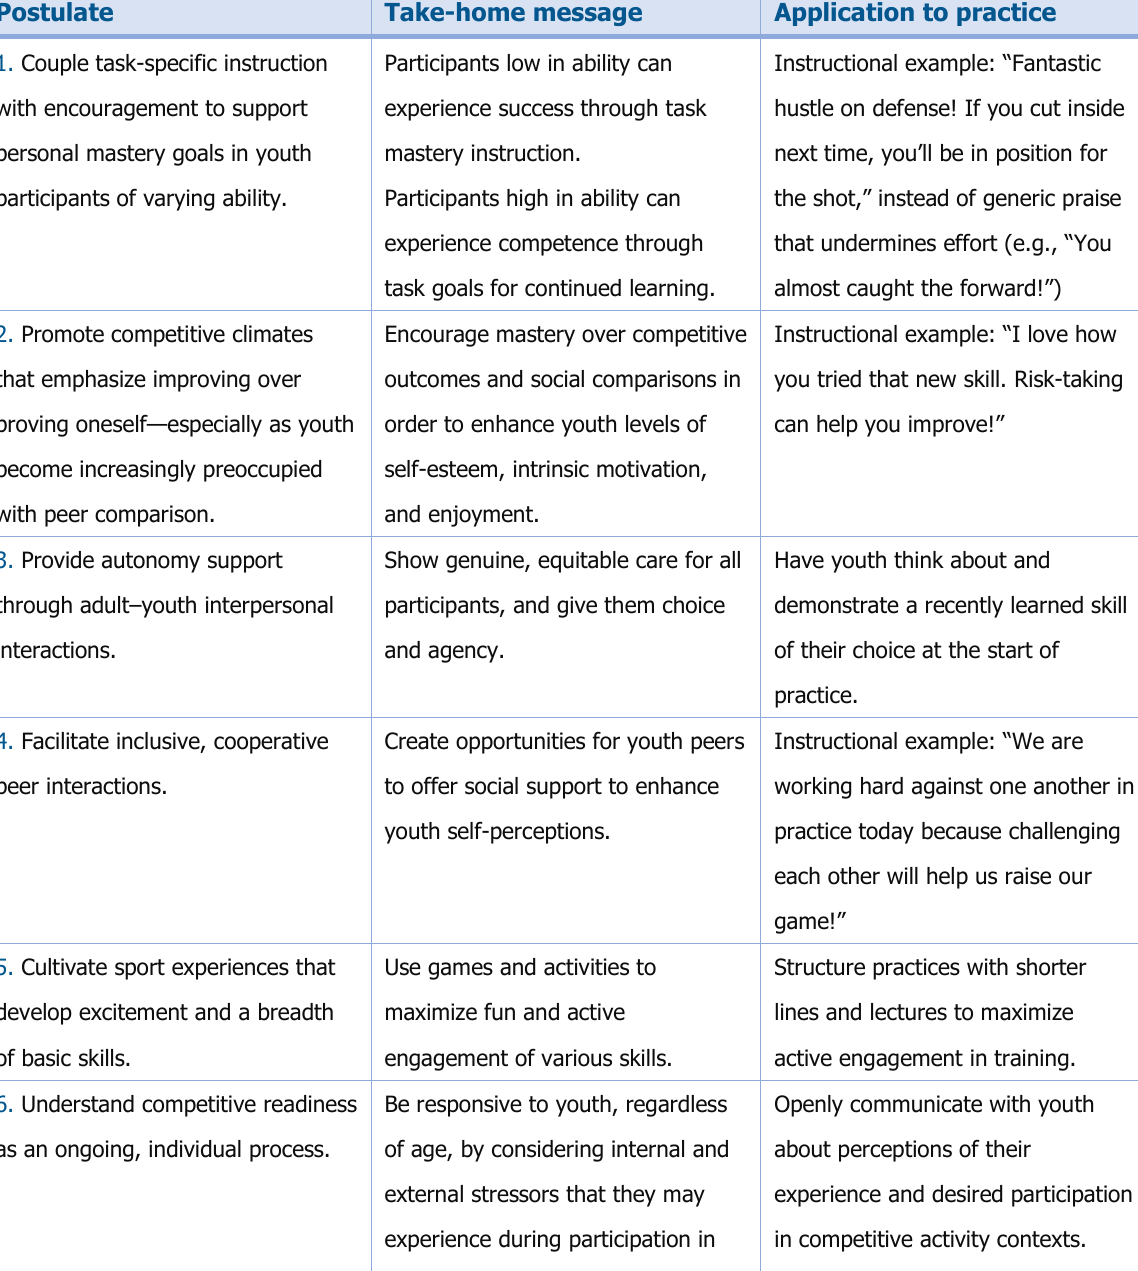
Table 1. Postulates, Take-Home Messages, and Applications to Practice for